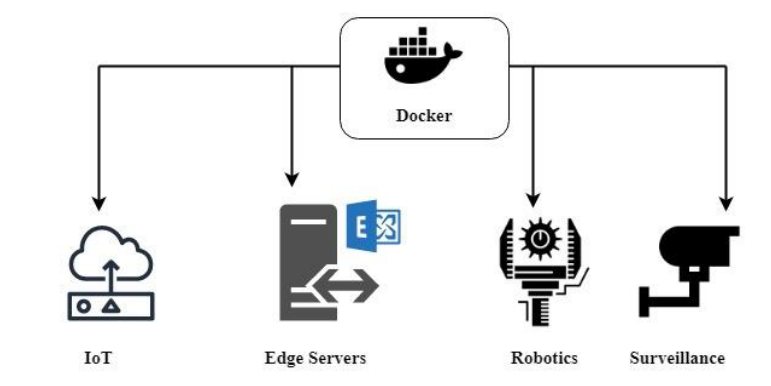
Figure 11. Deploy docker containers in